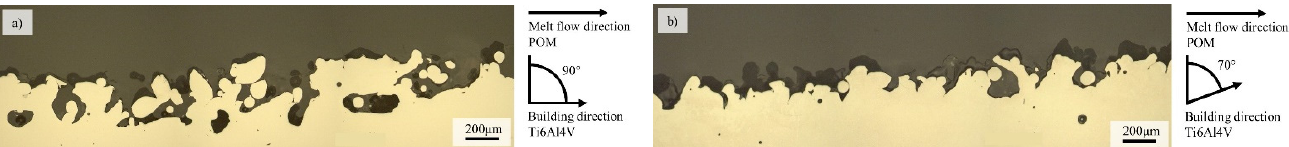
Figure 8. ( a ) Optical micrographs detailing the boundary layer of POM SLBV and the Ti6Al4V insert built at an angle of 90°. ( b ) Optical micrographs detailing the boundary layer of SLBV and the Ti6Al4V insert built at an angle of 70°.